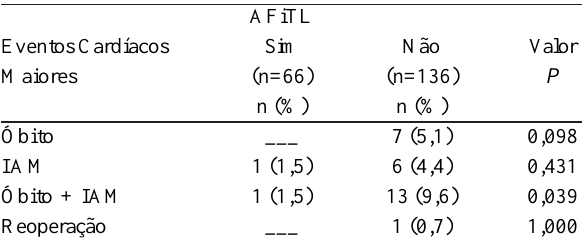
Tabela 3. Eventos Cardíacos Maiores na internação, conforme a prática de AFiTL pré-operatória.